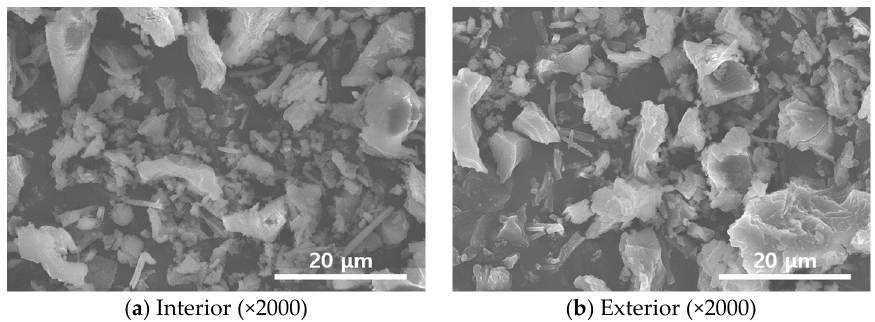
Figure 16. SEM imaging of carbonated magnesium from the interior ( a ) and exterior ( b